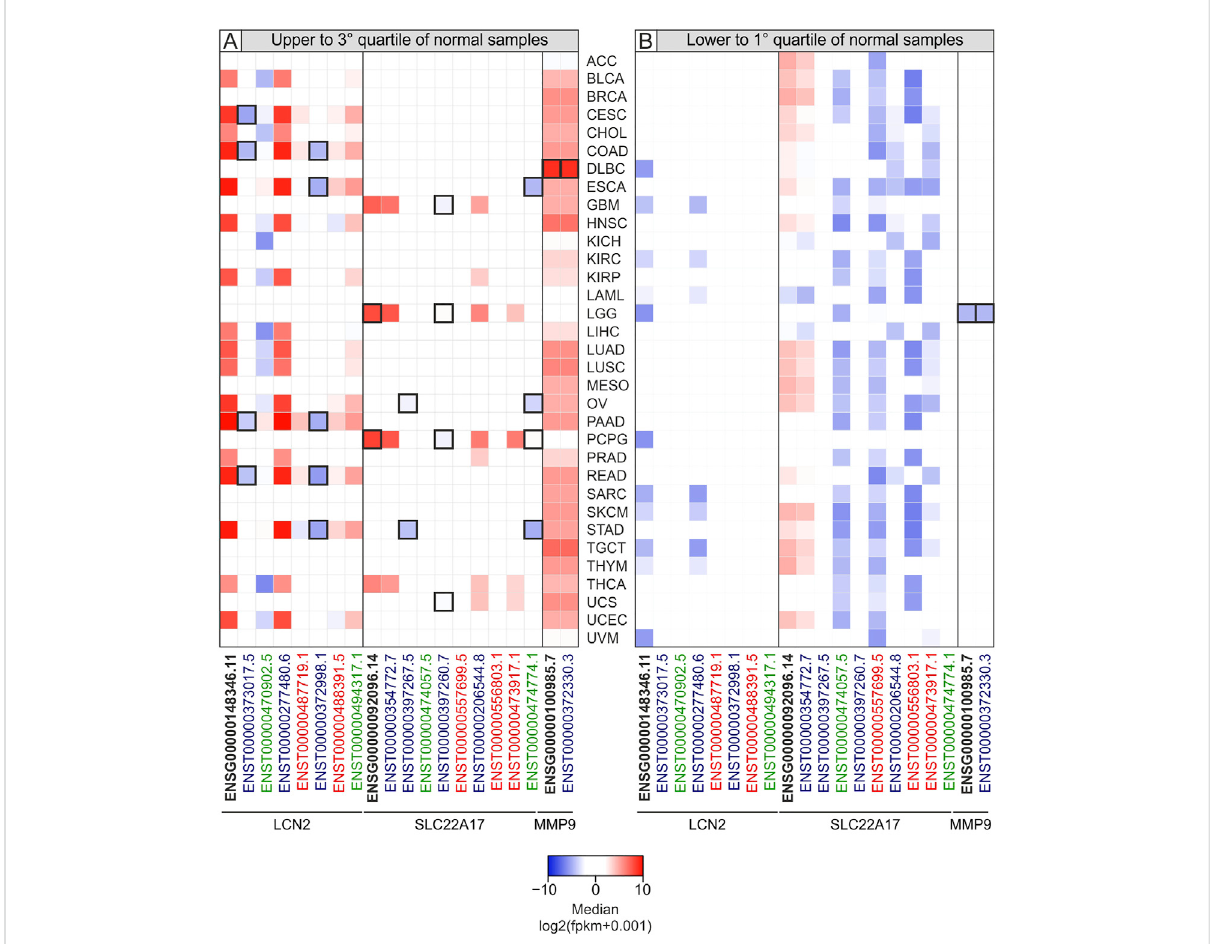
FIGURE 2 Heatmap ofmedian expressionlevels for LCN2 , SLC22A17 ,and MMP9 genesand isoforms intumor samples according to interquartile range of normal samplesmedian values. The medianvaluesofeach tumor typehigher than the3rdquartile (A) orlower than the1stquartile ofnormal tissues (B) are reported. The negative median values (lower expression) are shown as blue squares, while positive ones (higher expression) are indicated in red. Black border indicates the median values of each tumor type that are also outliers. Black bold labels indicate the LCN2 , SLC22A17 , and MMP9 genes (ENSG). Coding ENST isoforms: blue; non-coding ENST isoforms: green; retained intron ENST isoforms: